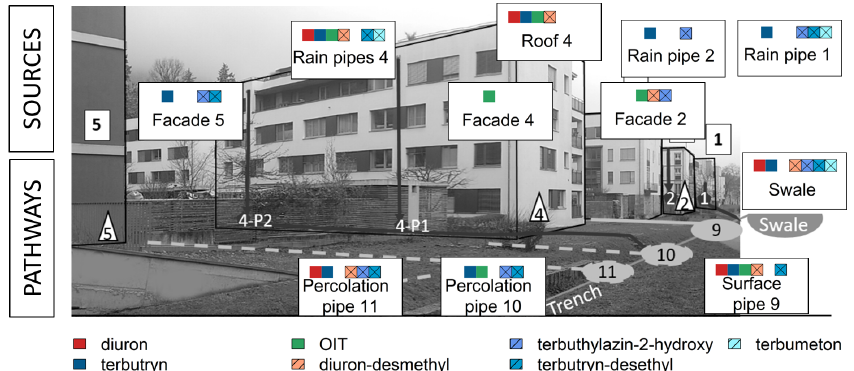
Figure 10. Qualitative overview of biocides and their TPs in the investigated water infrastructures. Shown colors at sampling points represent detected substances. For the legend of the background picture, refer to Fig.